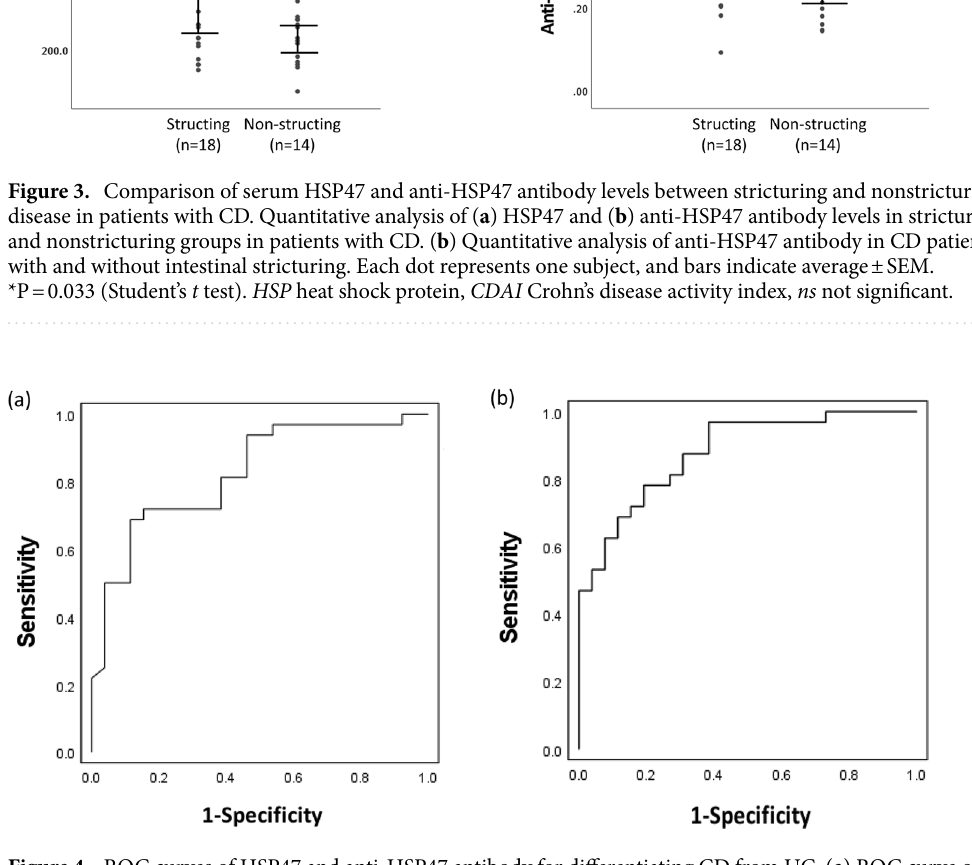
Figure 4. ROC curves of HSP47 and anti-HSP47 antibody for differentiating CD from UC. ( a ) ROC curve of HSP47 showing an AUC of 0.824. ( b ) ROC curve of anti-HSP47 antibody showing an AUC of 0.880. HSP heat shock protein, CD Crohn’s disease, UC ulcerative colitis, ROC receiver operating characteristics, AUC area under the